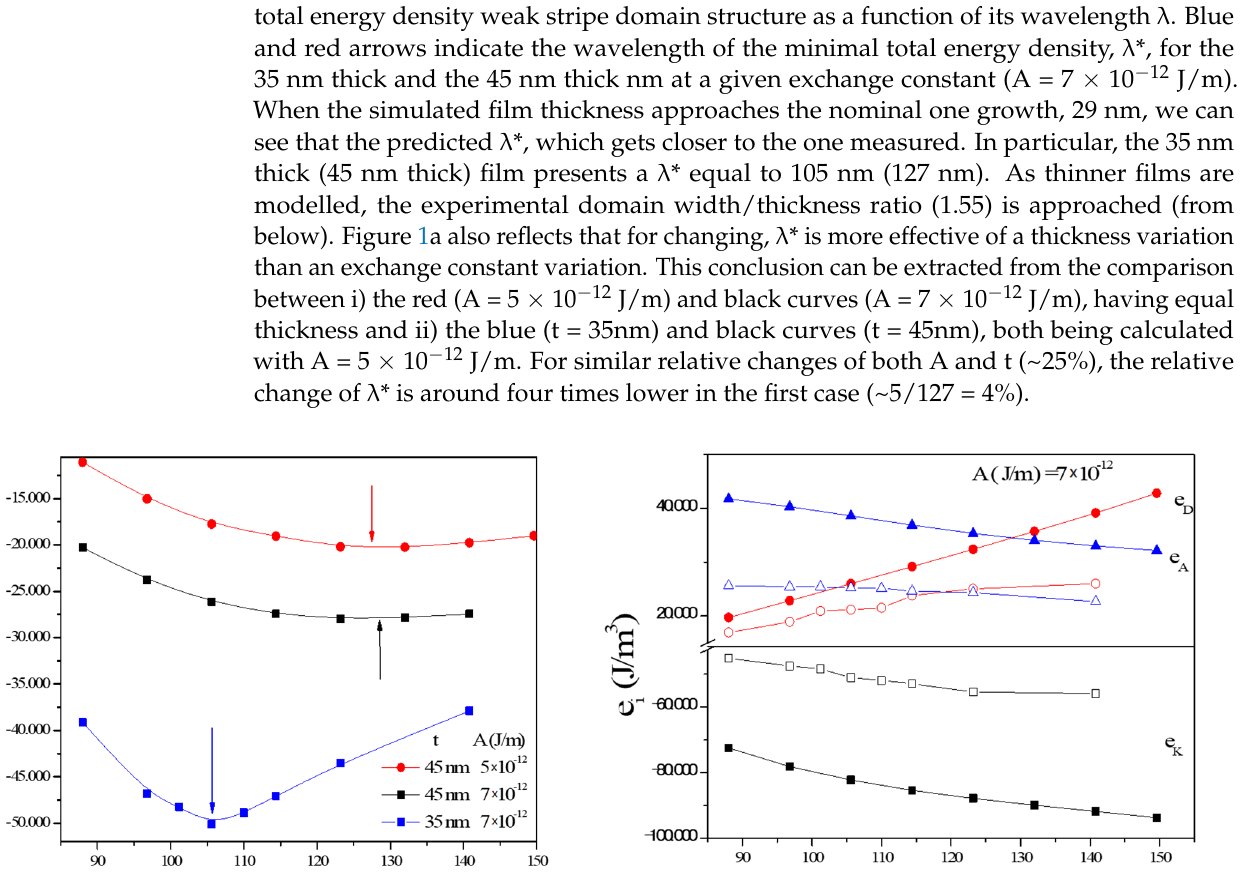
Figure 1. ( a ) Variation of the total energy density as a function of the stripe domain wavelength for a 45 nm thick (red and black) and 35 nm thick (blue) NdCo 5 ; ( b ) energy density contributions for 45 nm thick (full dots) and 35 nm thick (empty squares) NdCo 5 films. The exchange is kept constant for ( b ). No external magnetic field is considered.